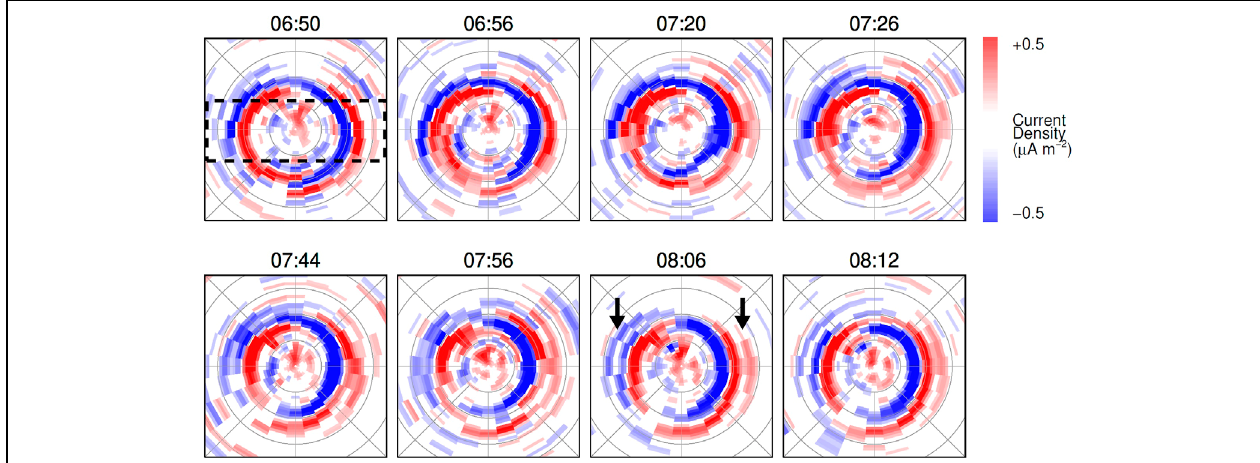
FIGURE 1 | A series of eight northern hemisphere polar plots from Sangha et al. (2020), showing the development of AMPERE field-aligned current densities during a FAC bifurcation event, from 06:50 to 08:12 UT on 2 June 2011. The color scale shows upward (red) and downward (blue) FACs, saturating at ± 0.5 μ A m −2 . The gray concentric rings show the colatitude in steps of 10 ° , up to 35 ° . 12 MLT (local noon) is located at the top of the plots, with 06 MLT (dawn) on the right. The dashed box indicates the axis of interest - the dawn-dusk axis. The locations of interest are indicated with the black arrows in the 08:06 UT panel, where there are R2Bs present in both the dawn and dusk regions. The first panel shows the standard R1/R2 pattern, which evolves and by 07:44 UT the polar cap is seen to have contracted, with R2Bs clearly evident ∼ 25 ° to 30 ° (Sangha et al., 2020).